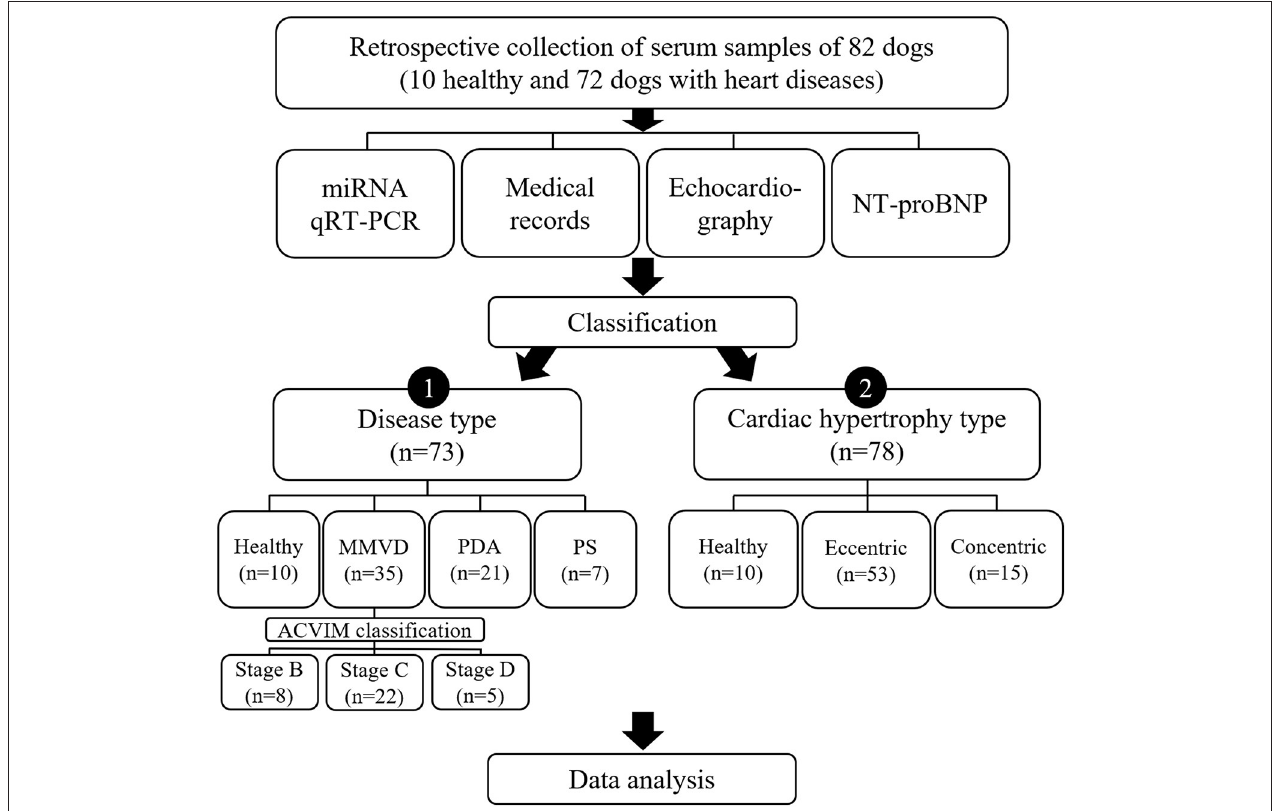
FIGURE 1 | Study design. Results of qRT-PCR on 11 miRNAs, medical records, echocardiography, and NT-proBNP measurement in 82 dogs were analyzed in this study. To investigate different factors related to expression of miRNAs, the dogs included in this study were sub-grouped by two different classifications, classification by disease type and classification by cardiac hypertrophy type, and each classification was analyzed independently. ACVIM, American College of Veterinary Internal Medicine; miRNA, microRNA; MMVD, myxomatous mitral valve degeneration; NT-proBNP, N-terminal pro B-type natriuretic peptide; PDA, patent ductus arteriosus; PS, pulmonic stenosis; qRT-PCR, quantitative reverse transcription-polymerase chain